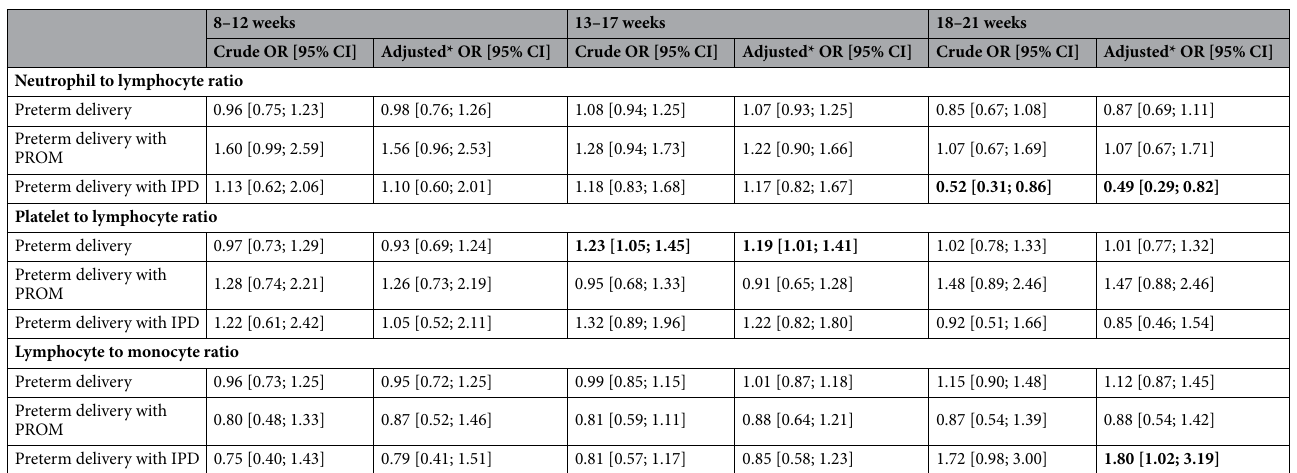
Table 2. Biomarker values at early pregnancy and risk of preterm delivery, stratified by timing of blood test. PROM premature rupture of membranes, IPD ischemic placental disease. *Adjusted model for sex of